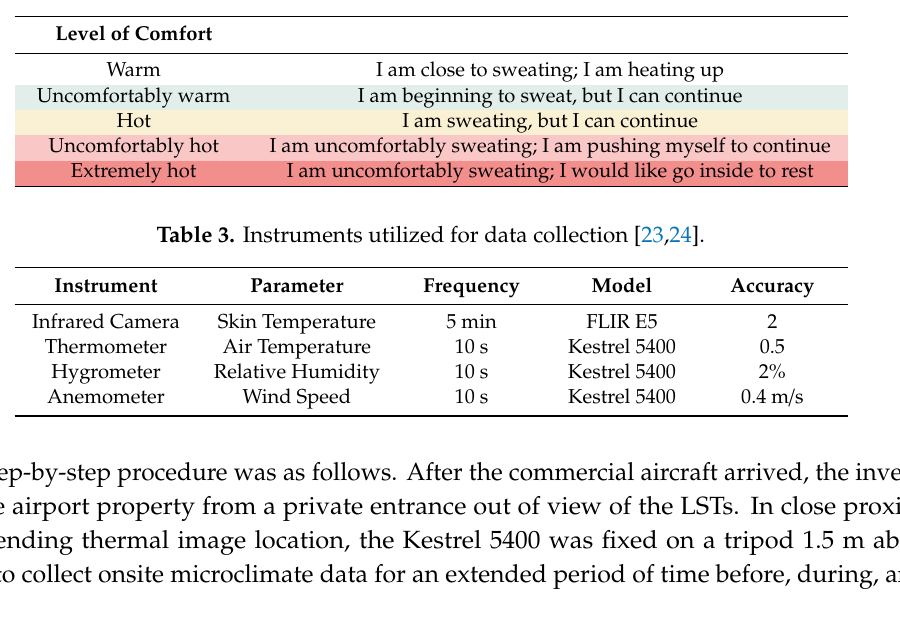
Table 2. Perceived thermal comfort-level indicators [25].